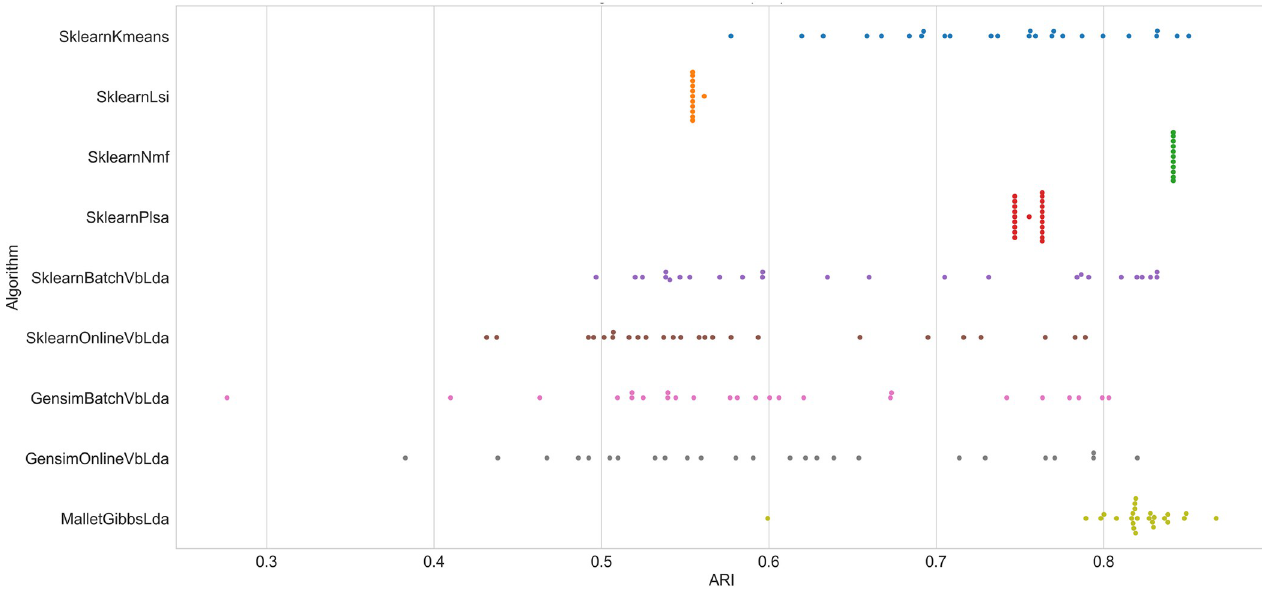
Fig 2. Algorithm performance (ARI) on the WikiA5 dataset.